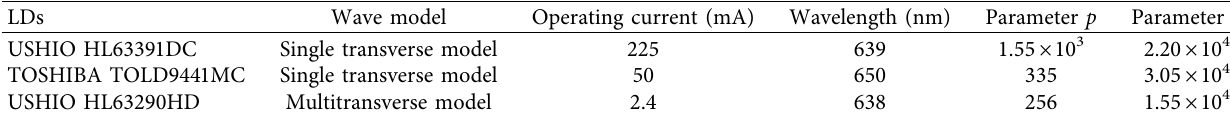
Figure 1: Facet of a LD chip and the related coordinate system. Table 1: Parameter of